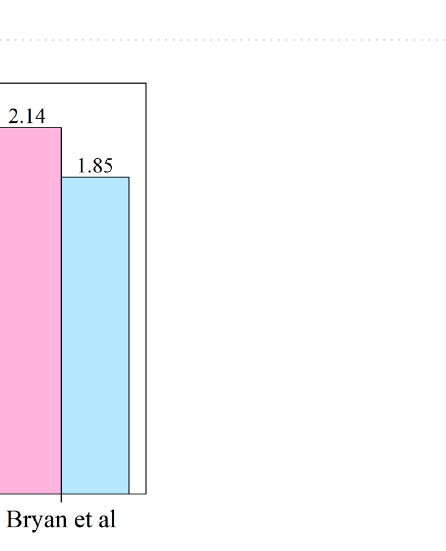
Figure 8. Evaluation of XGB-FE, XGB-FS and Bryan et al. 7 , performance by cross-plots between the model predictions and observed saturation in %DS-w ( 1 , 4 , 7 ), distribution of regular residuals ( 2 , 5 , 8 ), and quantile– quantile plots for comparing distributions between predictions and observations and evaluating normality of residuals ( 3 , 6 , 9 ).